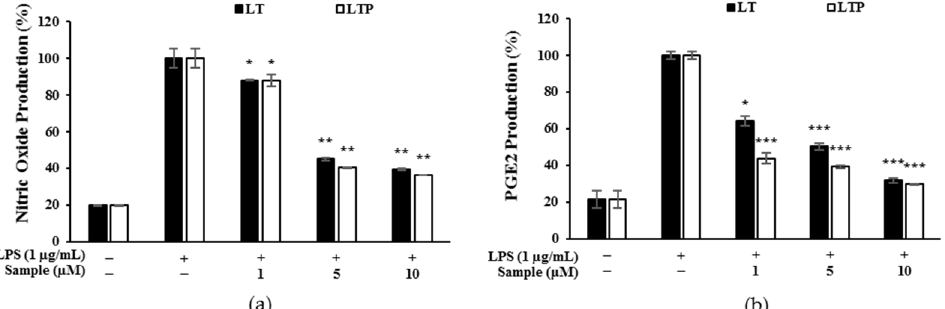
Figure 3. Effects of LT and LTP (at 1, 5, and 10 μ M) on ( a ) nitric oxide (NO) and ( b ) prostaglandin E2 (PGE 2 ) production in lipopolysaccharide (LPS)-stimulated RAW264.7 cells. Data are expressed as mean ± SD from three independent experiments (* p < 0.05, ** p < 0.01, and *** p < 0.001, compared to the LPS-treated group).